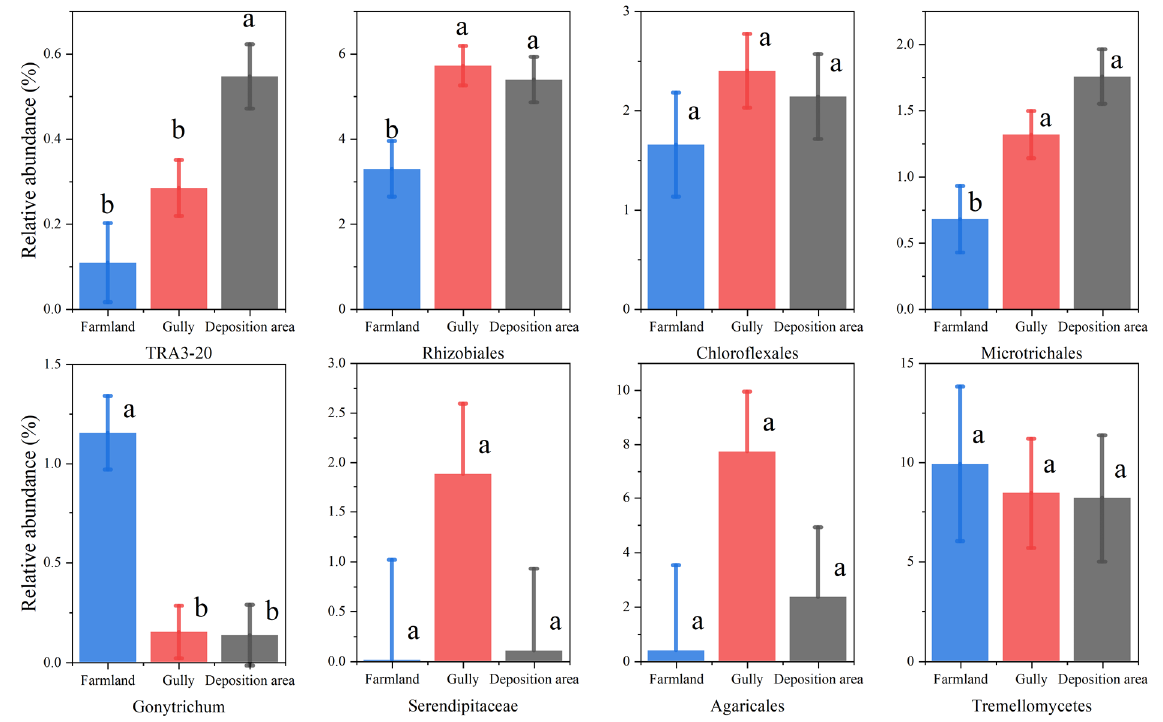
Figure 4. The abundance of biomarkers of gullies and farmland differed among farmland, gully, and deposition area in the Guangrong site. Error bars are twice the standard error of the mean. Means with the same lowercase were not a significant difference at p < 0.05 among farmland, gully, and deposition area.